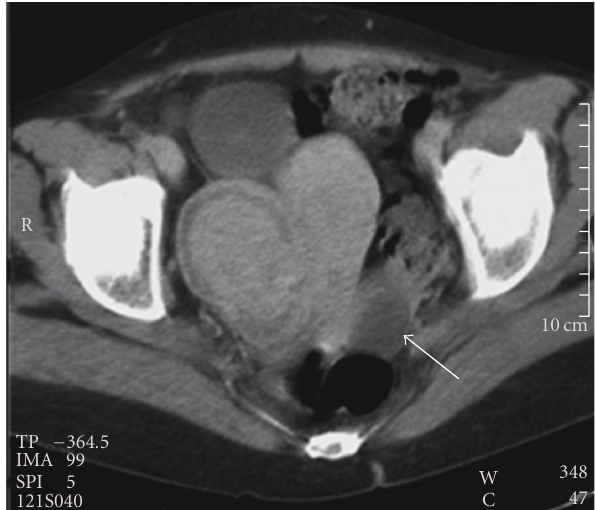
Figure 2: Contrast-enhanced CT of the pelvis showing a large myoma on the right side of the uterus. Note the cyst-like lesion in the left ovarium, without intraluminal nodules